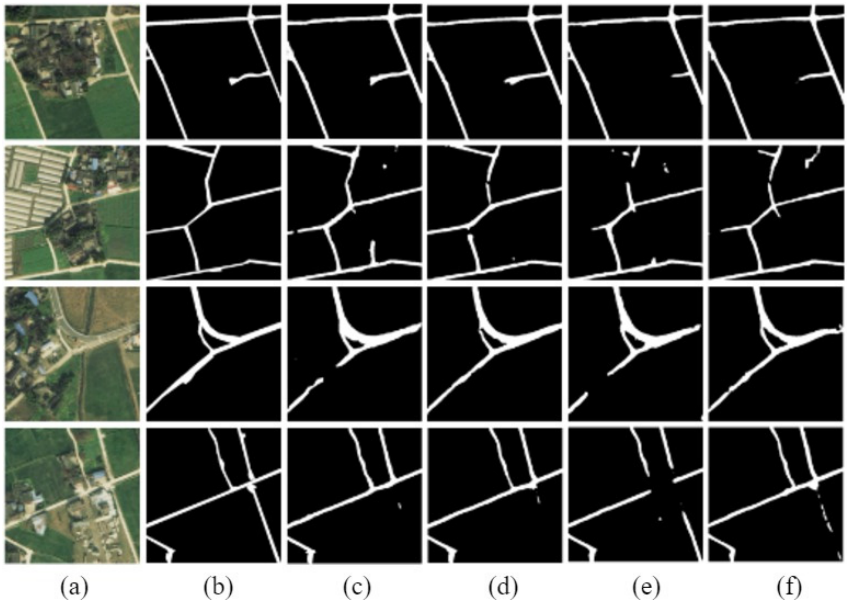
Figure 12. Comparison results of general scene experiments. ( a ) Input image; ( b ) label image; ( c ) D-